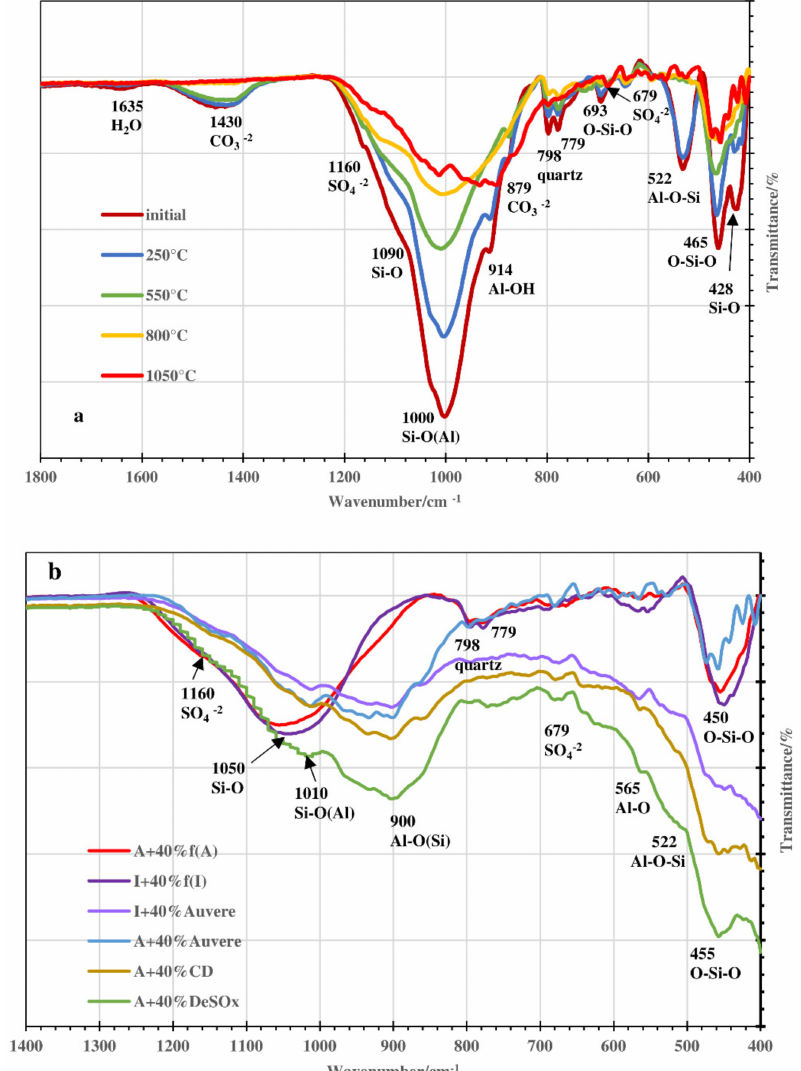
Figure 8. FTIR spectra of blend based on Arumetsa clay with 40% Auvere FA, H thermally treated at different temperatures ( a ) and blends based on Arumetsa and illitic clay with different additives thermally treated at 1050 ◦ C ( b